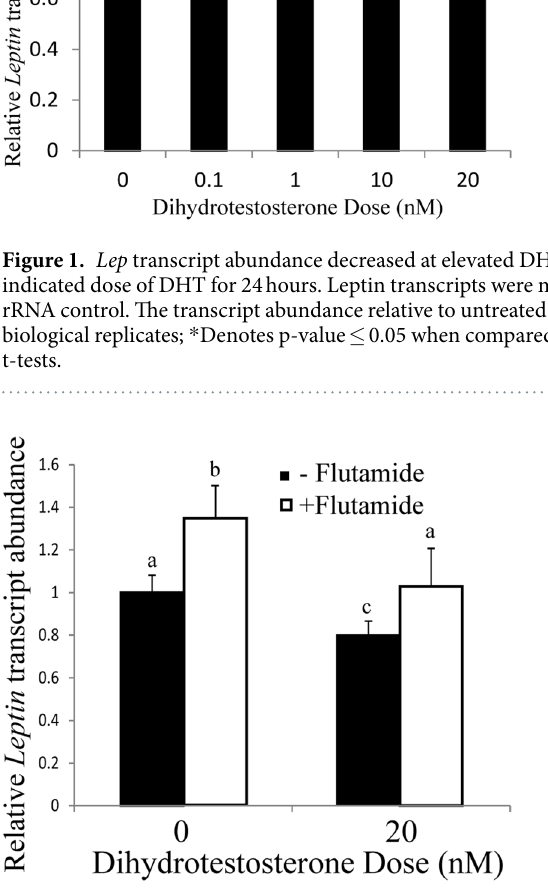
Figure 2. Lep transcript abundance decreased with 20 nM DHT and increased with 200 nM flutamide treatment. Leptin transcripts were measured by qRT-PCR and normalized to an 18 S rRNA control. The transcript abundance relative to untreated controls is reported as mean ± S.E.M with n ≥ 6 biological replicates. Means with different letters are statistically different using two-tailed Mann-Whitney